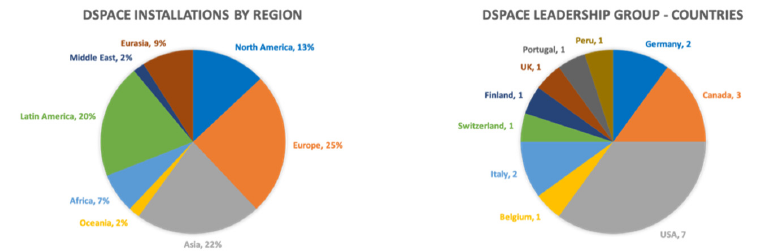
Figure 4. Installations of DSpace per Country and representatives in the Leadership Group as of March